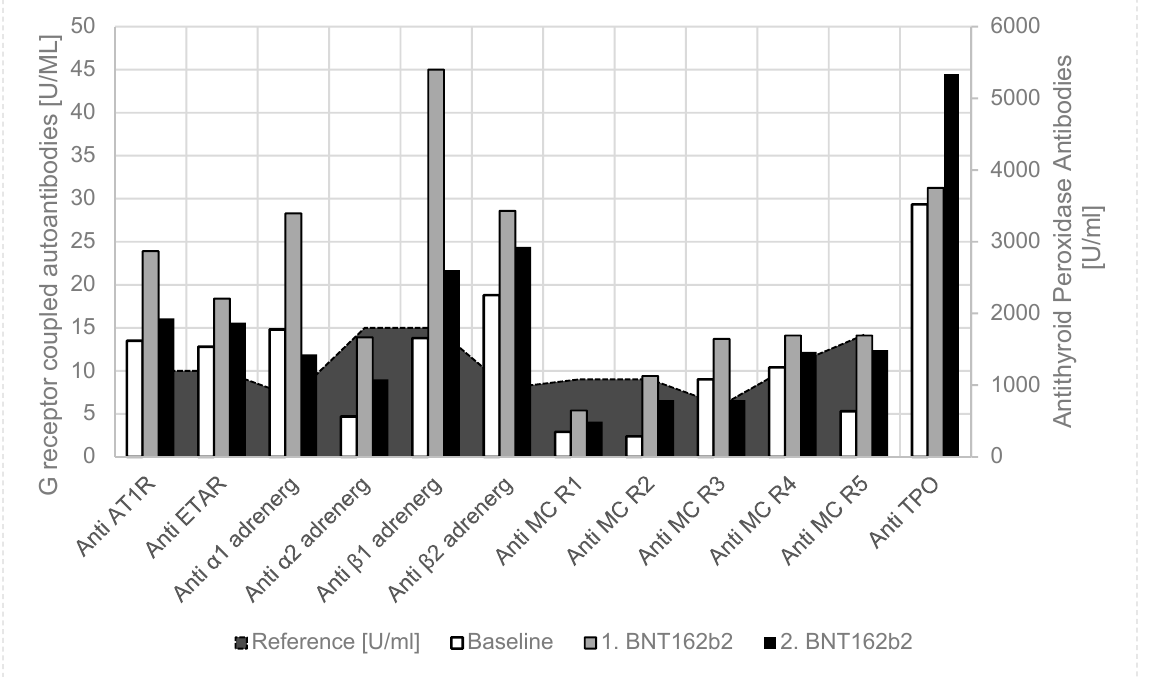
Figure 2. Case 2: Autoantibody release after Pfizer ‐ BioNTech BNT162b2 vaccination in a 13 ‐ year ‐ old girl with Hashimoto thyroiditis. Compared to healthy controls and the baseline values, we found a uniform increase of functional autoantibodies against G ‐ protein ‐ coupled receptors and antithyroid peroxidase antibodies in a girl with a known autoimmune disease (after the first BNT162b2 vaccination); however, there was a further increase of only the antithyroid peroxidase antibodies after the second vaccination. Anti ‐ AT1R : anti ‐ angiotensin 1 receptor autoantibody; anti ‐ ETAR : anti ‐ endothelin receptor autoantibody; anti ‐α 1 adrenerg : anti ‐α 1 adrenergic receptor autoantibody; anti ‐α 2 adrenerg : anti ‐α 2 adrenergic receptor autoantibody; anti ‐β 1 adrenerg : anti ‐β 1 adrenergic receptor autoantibody; anti ‐β 2 adrenerg : anti ‐β 2 adrenergic receptor autoantibody; anti ‐ MC R1 : anti ‐ muscarinic cholinergic receptor ‐ 1 autoantibody; anti ‐ MC R2 : anti ‐ muscarinic cholinergic receptor ‐ 2 autoantibody; anti ‐ MC R3 : anti ‐ muscarinic cholinergic receptor ‐ 3 autoantibody; anti ‐ MC R4 : anti ‐ muscarinic cholinergic receptor ‐ 4 autoantibody; anti ‐ MC R5 : anti ‐ muscarinic cholinergic receptor ‐ 5 autoantibody.